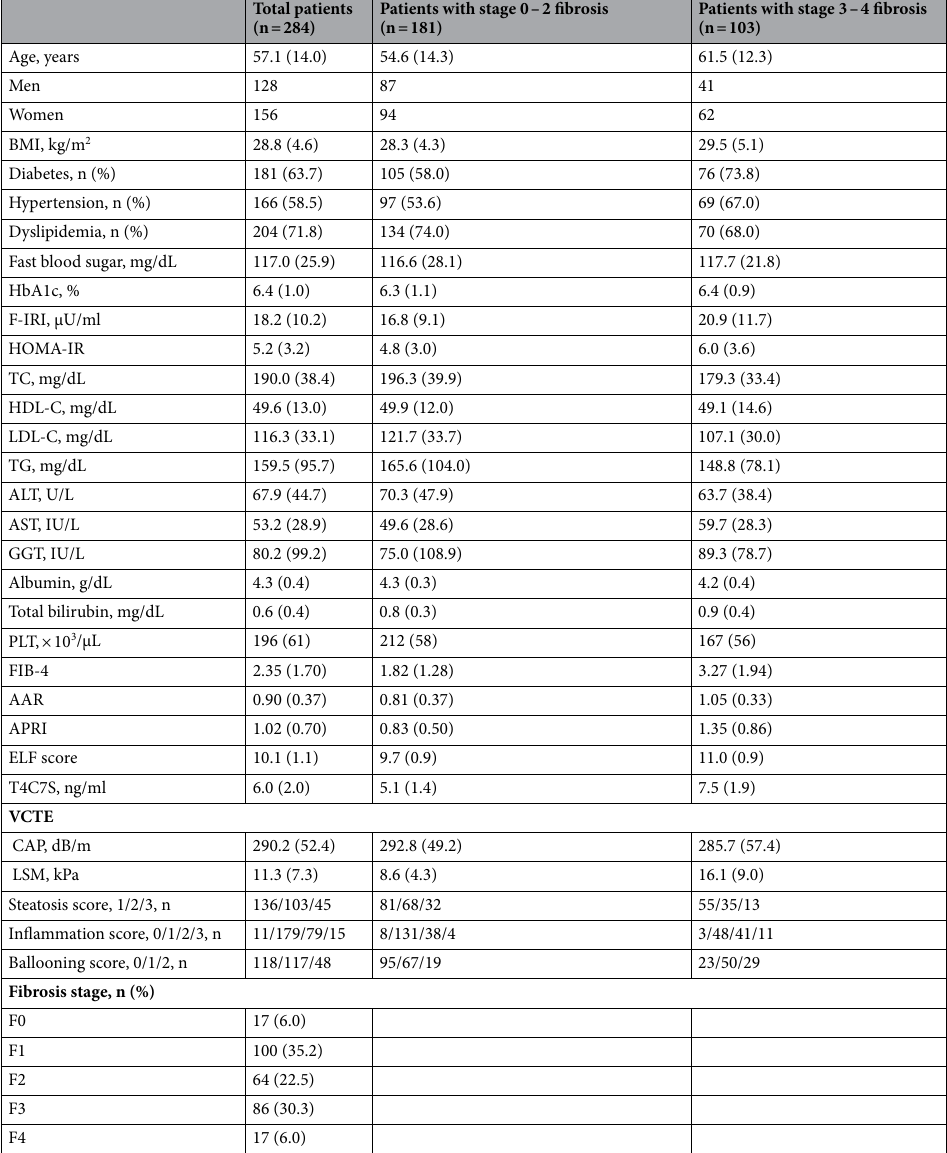
Table 1. Patient characteristics. Data are mean (SD) unless otherwise stated. AAR, AST/ALT ratio; ALT, alanine transaminase; APRI, AST to platelet ratio; AST, aspartate aminotransferase; BMI, body mass index; CAP, controlled attenuation parameter; ELF, enhanced liver fibrosis test; F-IRL, Fasting insulin resistance index; FIB-4, Fibrosis-4 index; GGT, γ-glutamyltranspeptidase; HDL, high-density lipoproteins; HOMA-IR, Homeostatic Model Assessment of Insulin Resistance; LDL, low-density lipoprotein; LSM, liver stiffness measurement; PLT, platelet count; T4C7S, type IV collagen 7S domain; TC, total cholesterol; TG, triglycerides; VCTE, vibration-controlled transient